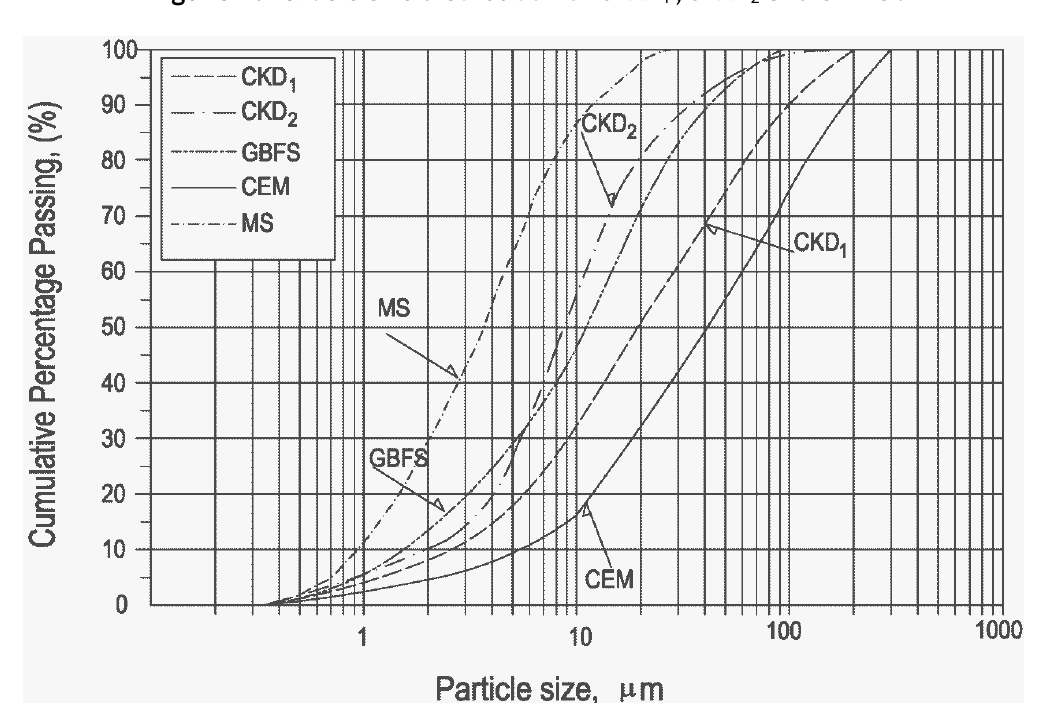
Figure 2. Particle size distribution of CKD